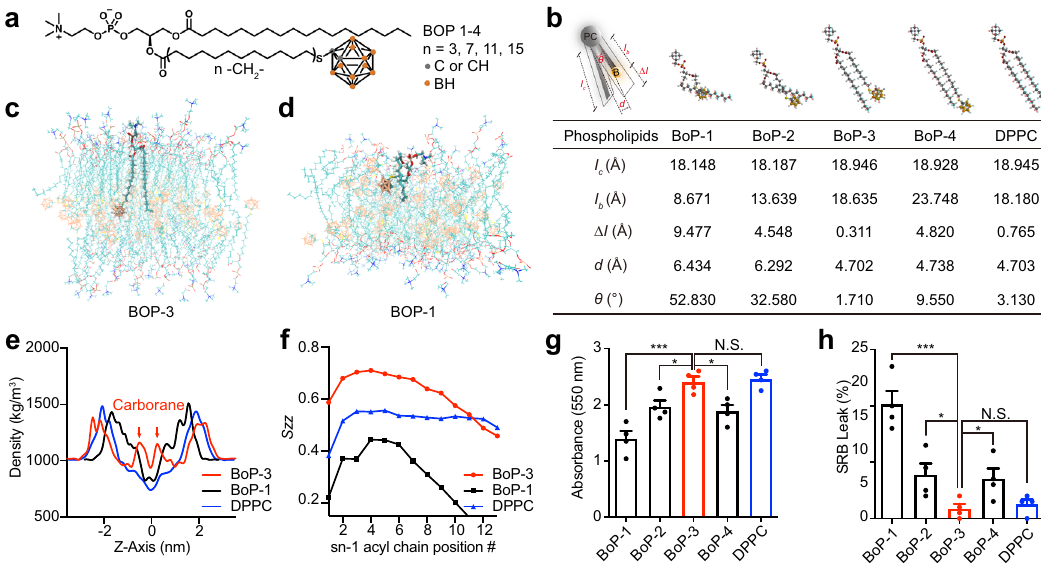
Fig. 2 Boronated phospholipids (BoPs) with hydrophobic tails of matched length show superior self-assembly and packing properties. a Chemical structure of BoPs with different lengths of alkyl chain. b Spatial con fi guration and structural parameters of corresponding BoPs. I c , carbon arm length (Å); I b , boron arm length (Å); Δ l , length difference between lipid arms (Å); d , distance between lipid arms (Å); θ , dihedral angle between lipid arms (°). c Cross- sectional area of bilayers formed from BoP-3 and Dipalmitoylphosphatidylcholine (DPPC) in a 10 ns, 128 monomer MD simulation. Lipids are depicted in wireframe format. d Cross-sectional area of bilayers formed from BoP-1 and DPPC in a 10 ns, 128 monomer MD simulation. Lipids are depicted in wireframe format. e BoPs and DPPC density (excluding water contribution) post 10 ns MD simulation. f Chain order parameter ( S ZZ ) for BoPs following 10 ns MD simulation. S ZZ indicates order of lipid chain with respect to bilayer normal vector. Error bars show range for last two adjacent 10 ns block means. g Encapsulation of SRB ( n = 4) by various BoPs and DPPC under same conditions. *** p = 0.0010, BoP-2 vs BoP-3: * p = 0.0264, BoP-4 vs BoP-3: * p = 0.0126. h Release of SRB from boronsomes ( n = 4) with various BoPs and DPPC in 50% bovine serum at 37 °C after 24 h. *** p = 0.0003, BoP-2 vs BoP-3: * p = 0.0358, BoP-4 vs BoP-3: * p = 0.0433. Three independent experiments were performed and representative results are shown. N.S., no signi fi cant difference, data are shown as mean ± SEM, two-tailed unpaired Student ’ s t test. Source data are provided as a Source Data fi represents the length of palmitoyl lipid arm; l b , represents the Supplementary Fig. 2). Through a 10 ns simulation, the bilayer length of the carboranyl-lipid arm; Δ l : represents the length dif- density plot (Fig. 2e) indicated that BoP-3 generates a thicker ference between lipid arms; d : represents the distance between bilayer (5.24 versus 3.93 nm with the Gibbs – Luzzati criterion) lipid arms; θ : represent the dihedral angle between lipid arms. compared to BoP-1 (Supplementary Table 4). The chain order parameter ( S ZZ ) indicates the orientation of the lipid chain with respect to the bilayer normal. Values near 1 indicate an average orientation parallel to the bilayer normal and values closer to 0 indicate an orientation away from bilayer normal. As shown in Fig. 2f, positions of the sn-1-palmitoyl chains in BoP-3 bilayers had less disorder than other lipid bilayers based on an average